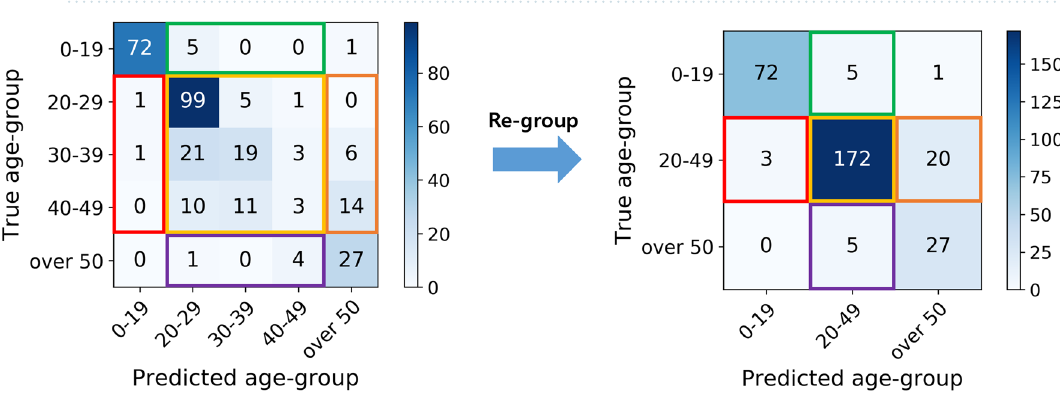
Figure 2. Classification of a panoramic dental X-ray using learned networks to predict age-group of the patient.